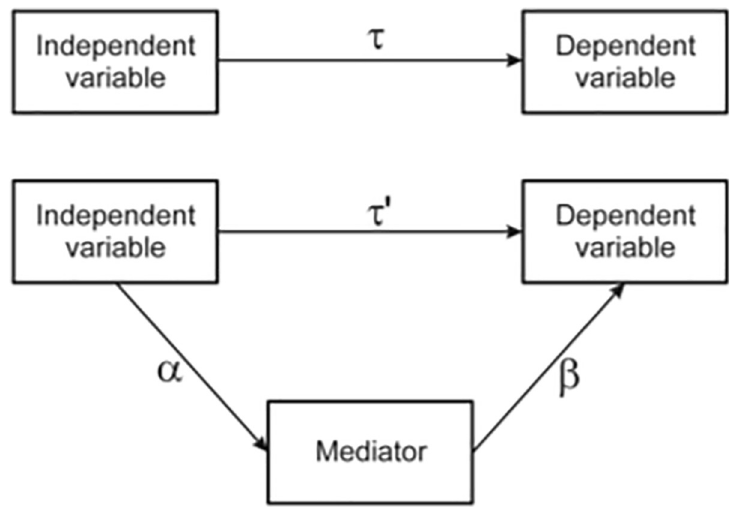
Fig 5. Mediation